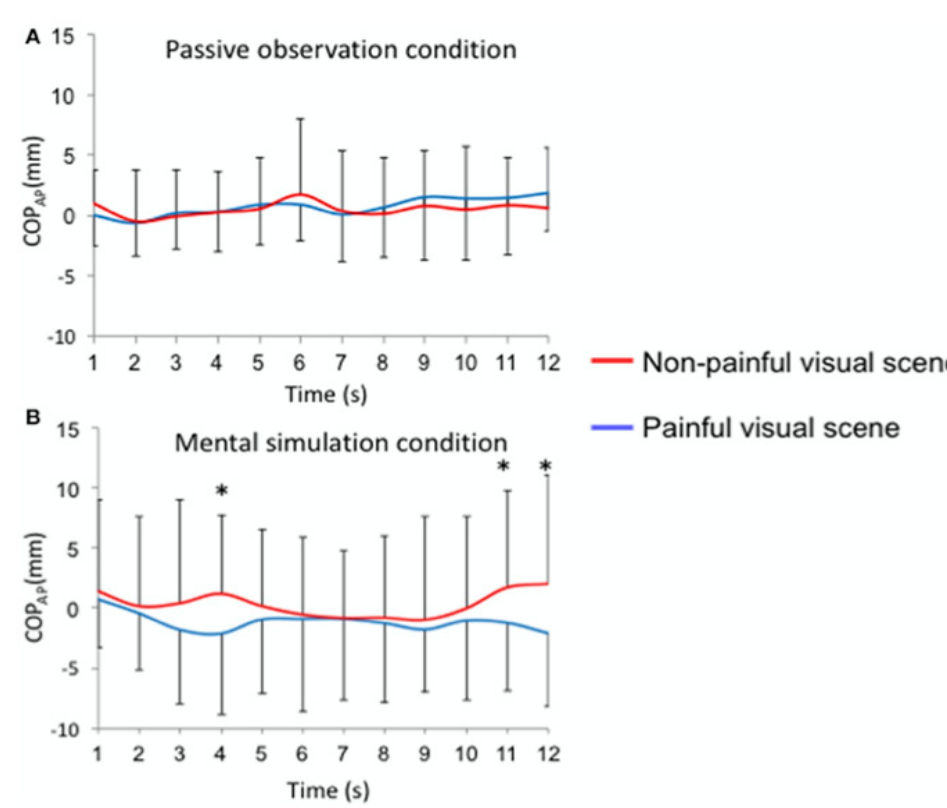
Figure 2. Time course of the anteroposterior position of the COPAP for each visual stimulus (painful vs. non painful visual scenes). Mean ( ± SEM) sliding window (1 s): ( A ) passive observation condition; ( B ) mental simulation condition, * p < 0.05. First published in Lelard T, Godefroy O, Ahmaidi S, Krystkowiak P, Mouras H. Mental simulation of painful situations impacts posture and psychophysi- ological parameters. Frontiers in Psychology 2017; 8: